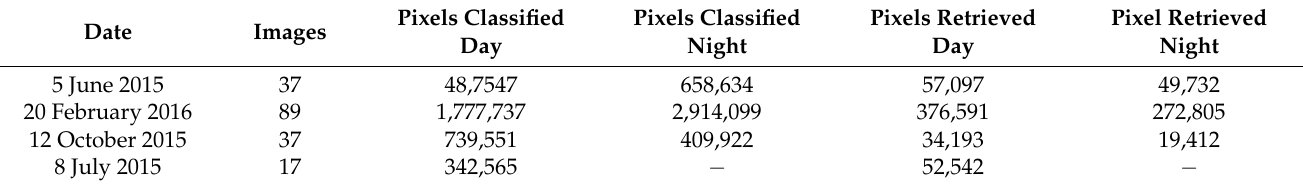
Table 9. Number of pixels processed for performance